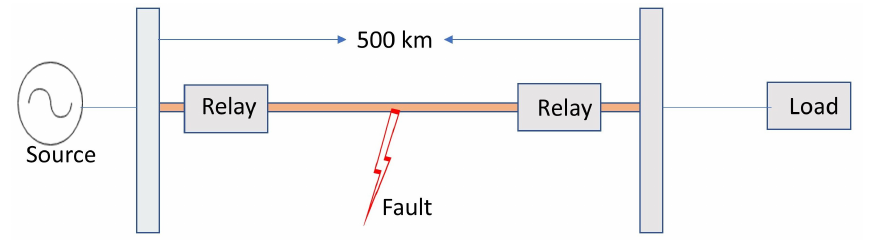
Figure 1. A 330 kV three-phase, 500 km transmission line